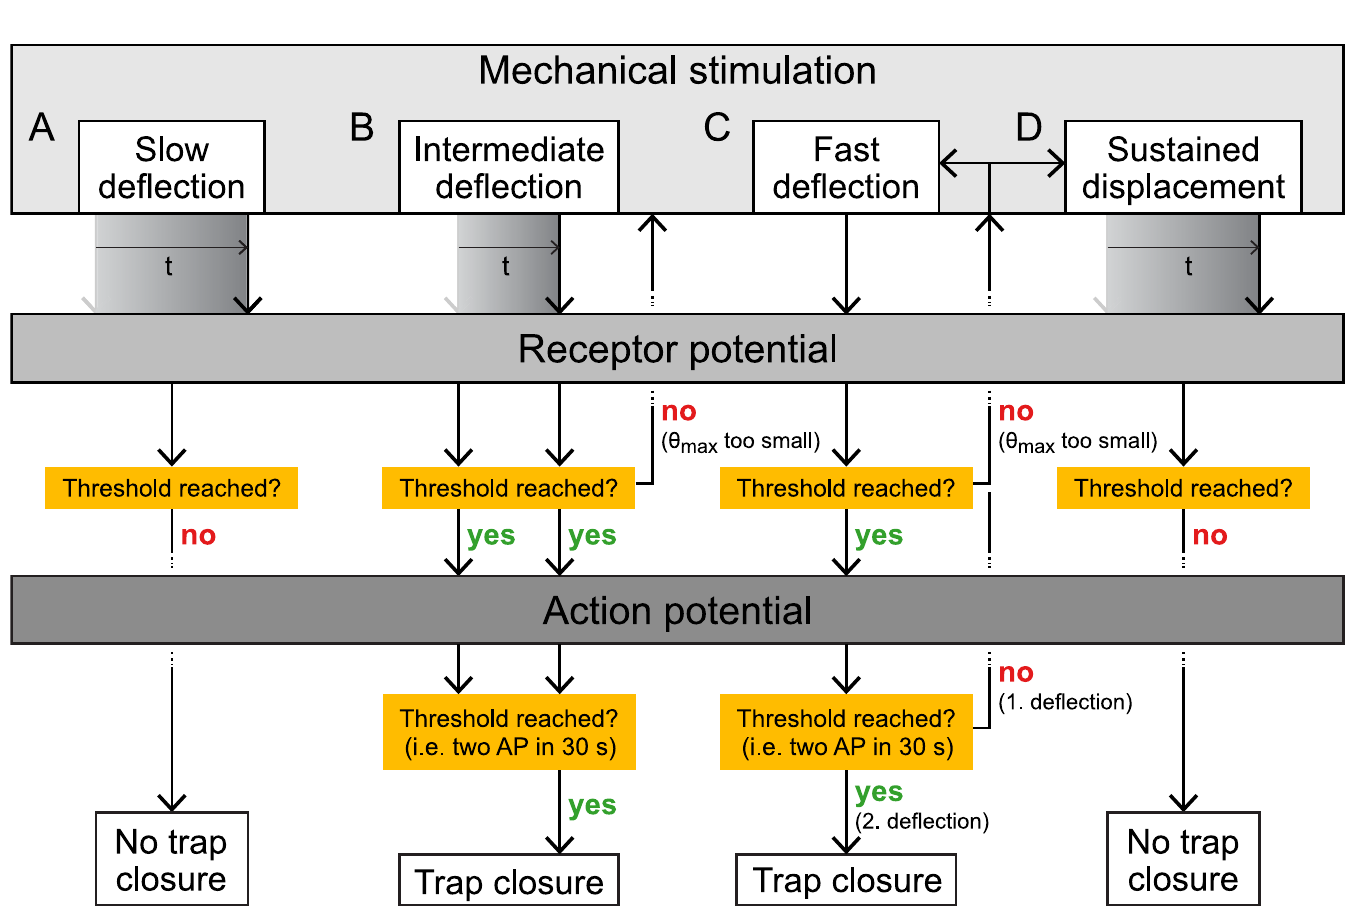
Fig 6. Schematic summary of the closing behavior of a Venus flytrap when its sensory hair is subjected to various controlled mechanical stimuli. (A) A low angular velocity cannot fill up the RP and does not create an AP. (B) A deflection at an intermediate angular velocity keeps the RP close to its threshold and can lead to the release of two APs triggering the trap. (C) A fast deflection results in an AP if the deflection is larger than the angular displacement threshold θ repeated a second time within about 30 s, a second AP will result in trap closure. Repeating deflection below θ th can fill up the RP to emit an AP. (D) Sustained displacement is a combination of a fast displacement as in (C) with keeping the sensory hair bent at a constant displacement. A single AP is generated during the initial step. While the sensory hair is kept deformed, however, no RP is built up, and the trap will not close. AP, action potential; RP, receptor potential.